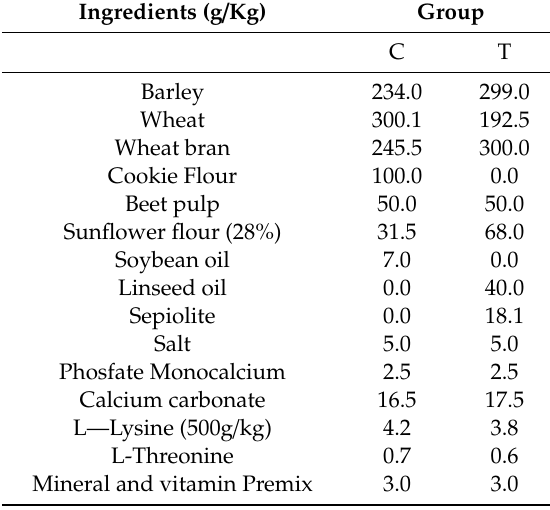
Table 1. Ingredient composition of experimental diets of sows (C = control group; T = treated